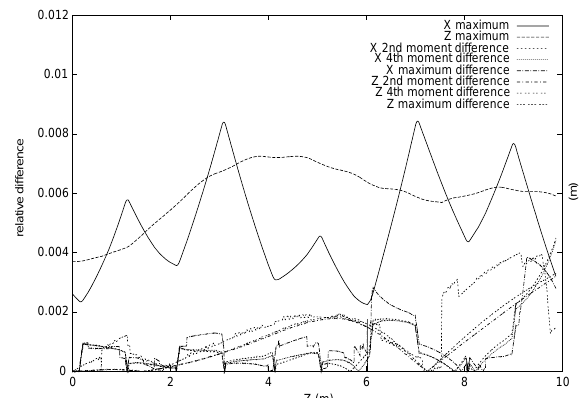
FIG. 5. The relative difference and maximum particle ampli- tude as a function of position using 400 mA current in the ref- erence case.